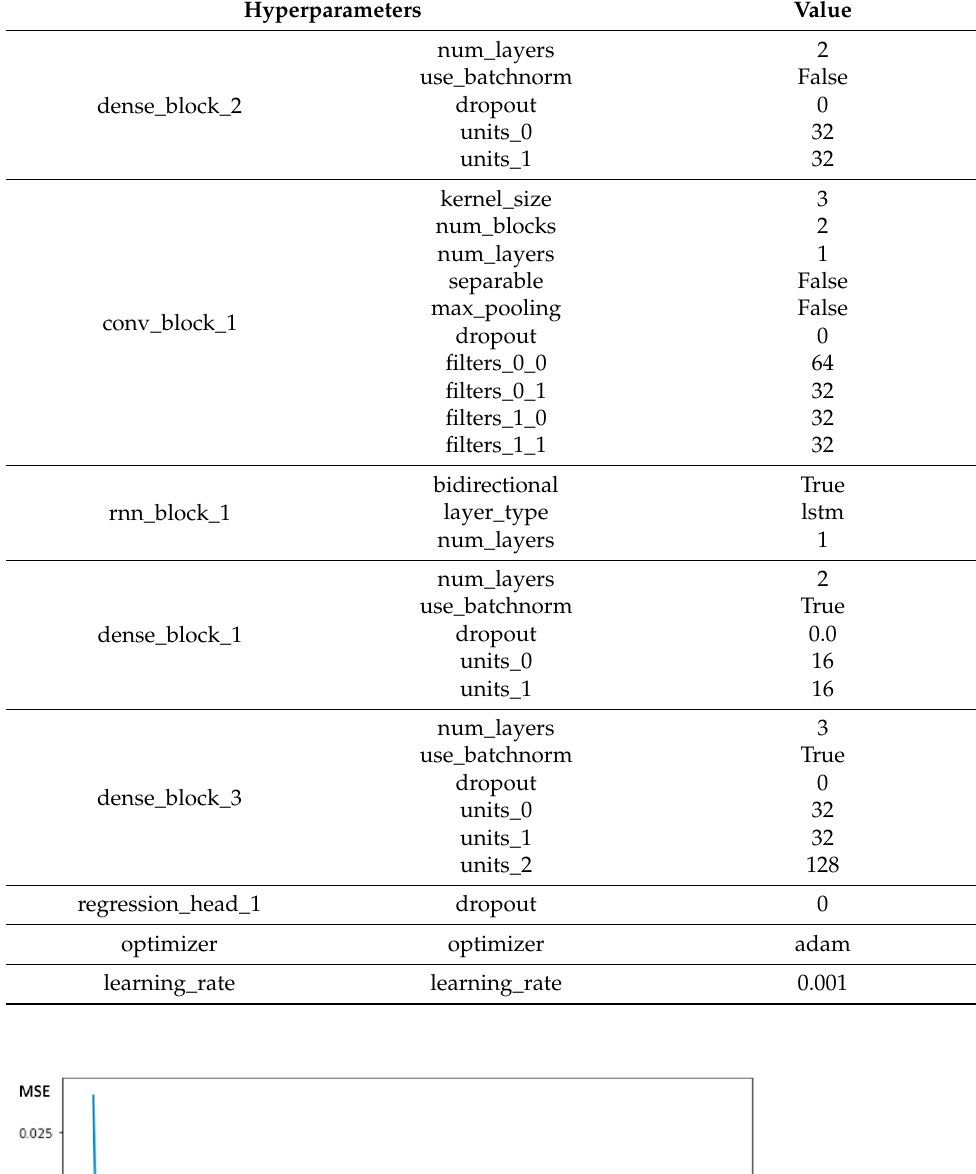
Table 4. Best hyperparameters.